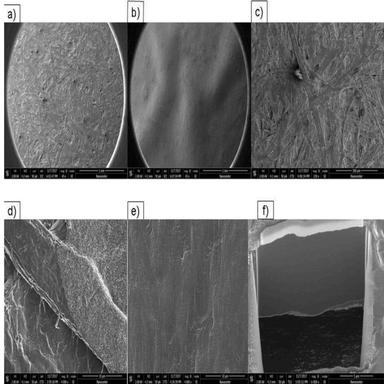
SEM-EDXS micrographs of the IT paper: upper surface at low magnification a), food-facing surface at low magnification b), upper surface at higher magnification with print spot c), upper surface at higher magnification with partly printed area d), food - facing surface at higher magnification e), FIB crosssection f).